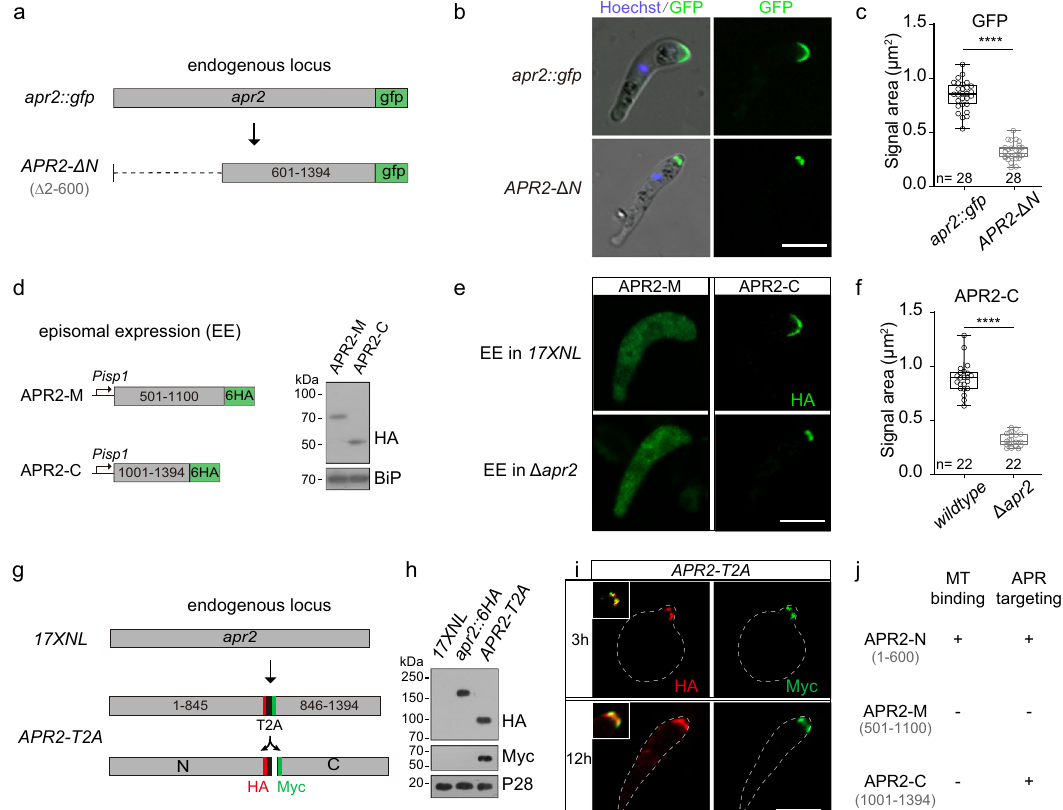
Fig. 5| APR2C-terminalregioncould localizeatAPR.a Diagramoftruncationof N-terminal fragment (2 – 600 aa) in endogenous APR2 in the parental parasite apr2::gfp ,generatingthe APR2- Δ N strain. b FluorescenceofGFPinthe apr2::gfp and APR2- Δ N ookinetes. Scale bars: 5 μ m. Two independently performed experiments with similar results. c Quanti fi cation of GFP signal area in b . Boxes show medians with interquartile ranges, whiskers: min to max show all points. n =28 cells exam- ined in both groups. **** P =3e − 24, two-sided Mann – Whitney test. d Diagram and con fi rmationofepisomalexpression(EE)forHA-taggedAPR2-M(501 – 1100aa)and APR2-C(1001 – 1394aa).Immunoblotcon fi rmedtheAPR2-MandAPR2-Cexpressed in the wildtype ookinetes (1.0×10 6 ookinetes were lysed in each sample). BiP is a loading control. Two independently performed experiments with similar results. e IFA of HA-tagged APR2-M and APR2-C episomally expressed in 17XNL and Δ apr2 ookinetes. Scale bars: 5 μ m. f Quanti fi cation of APR2-C IFA signal area in e . Boxes